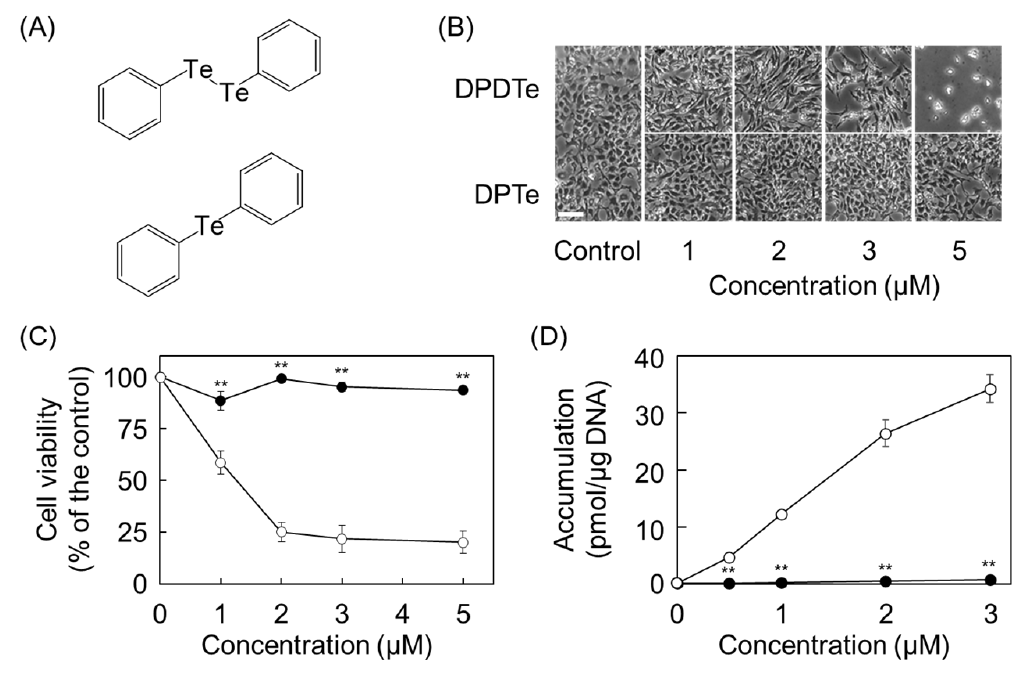
Figure 3. Assessment of contribution of the Te–Te bond to cytotoxicity of DPDTe. ( A ) Structure of DPDTe (top) and DPTe (bottom). ( B ) Morphological observation (bar = 50 µ m), ( C ) viability of vascular endothelial cells treated with DPDTe (white) and DPTe (black), and ( D ) intracellular accumulation of DPDTe (white) and DPTe (black) in vascular endothelial cells after treatment (0.5, 1, 2, 3, or 5 µ M) for 24 h. Values are expressed as the mean ± standard error of three replicates. ** p < 0.01 compared with the corresponding DPDTe treatment.